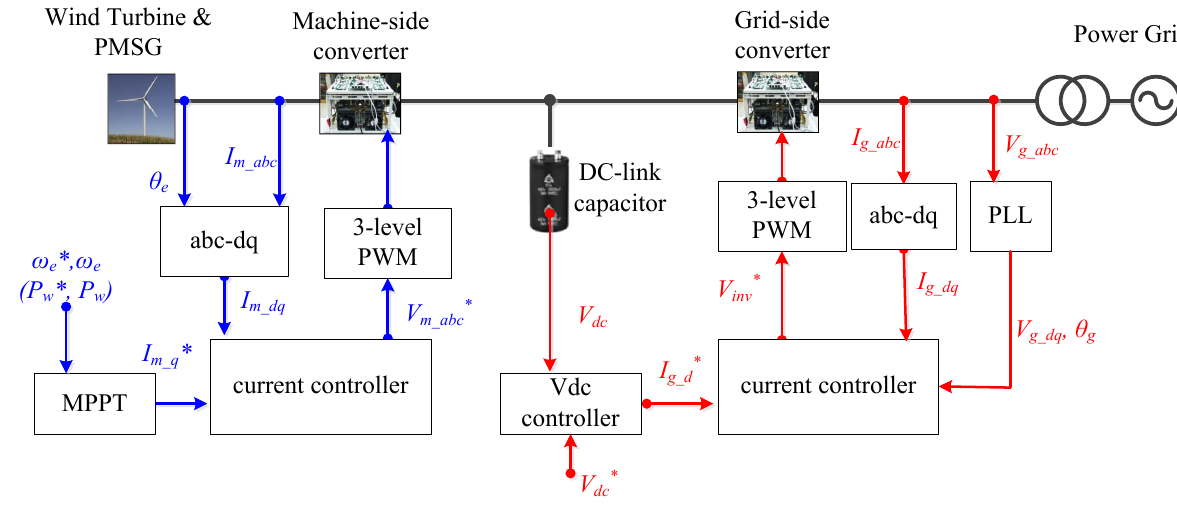
Figure 4. Configuration of wind power system and control block